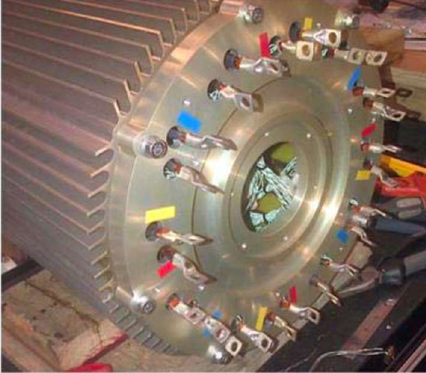
Figure 1. A fin-cooled electric tail motor [19].